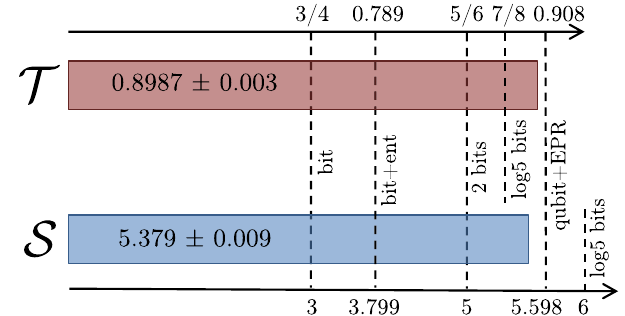
Fig. 3 | Experimental results . Illustration of the experimentally measured perfor- mance of the communication tasks and their comparison to the best conceivable protocols based on one bit of classical communication, one bit of classical com- munication assisted by unbounded entanglement, two bits of classical commu- nicationand fi ve-valuedclassicalcommunication.Thetwo-bitboundisequaltothe maximum attainable value using a dense coding protocol. Another dashed line represents the theoretical value of the targeted quantum protocol, based on a shared EPR pair and a communicated